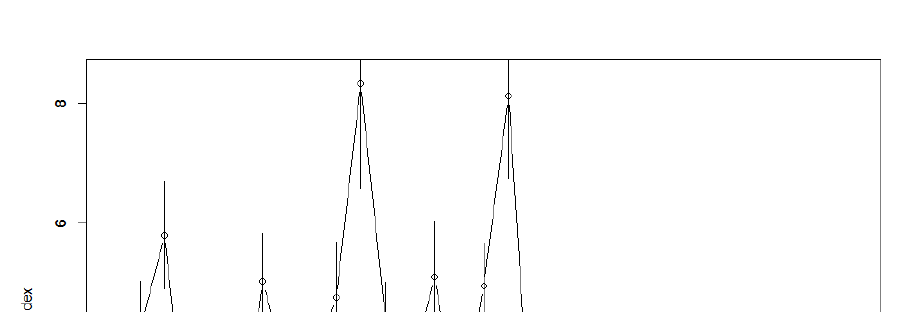
Figure 37. Index of relative abundance of horseshoe crab (delta mean catch per tow) in Jamaica Bay developed from the spring portion of the New York Seine Survey with 95% confidence intervals.